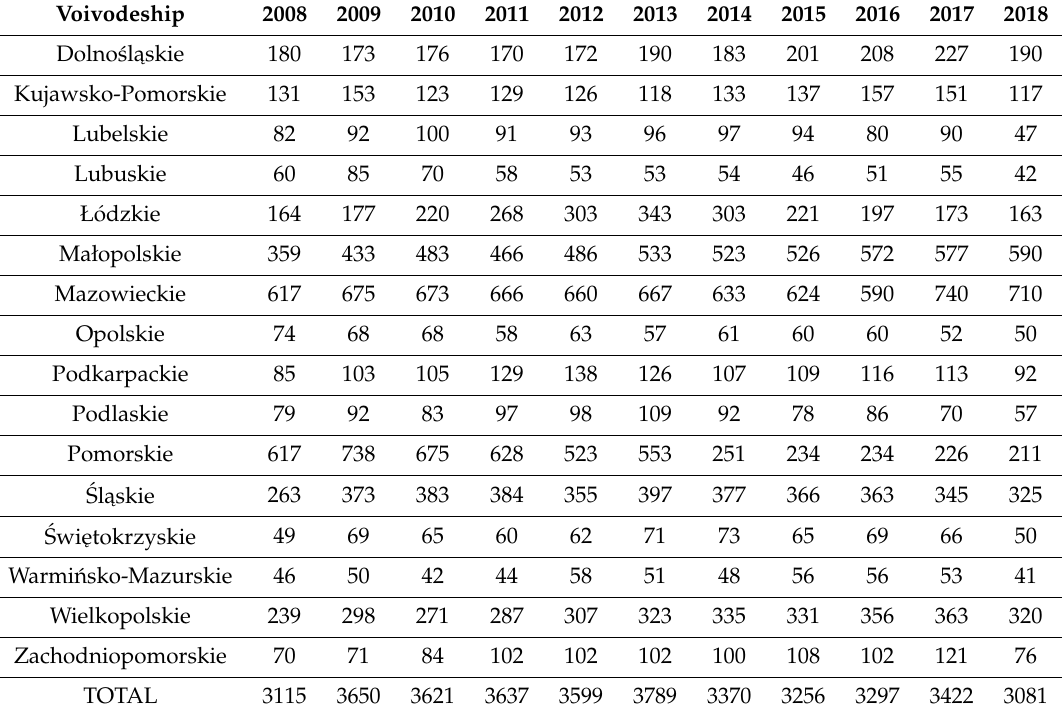
Table 2. Number of patients by voivodeships for all types of